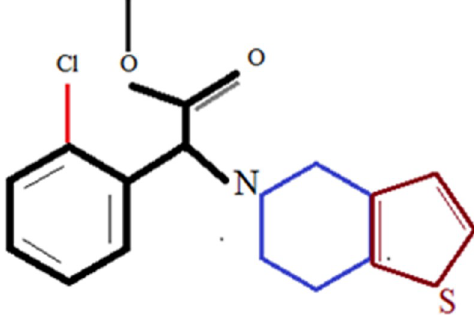
Fig 1. Structural formula of